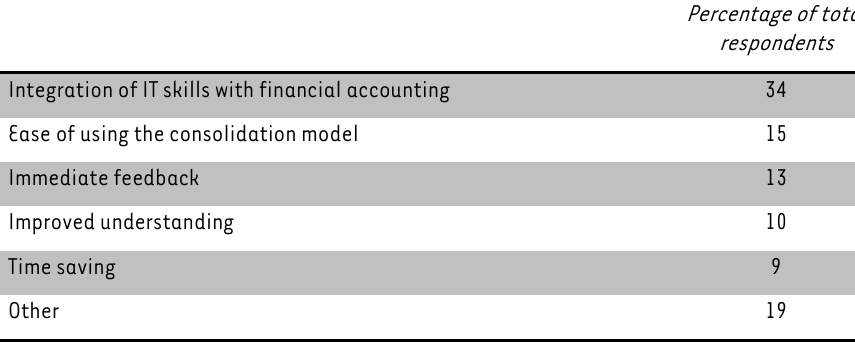
TABLE 5: Enjoyable aspects of the consolidation